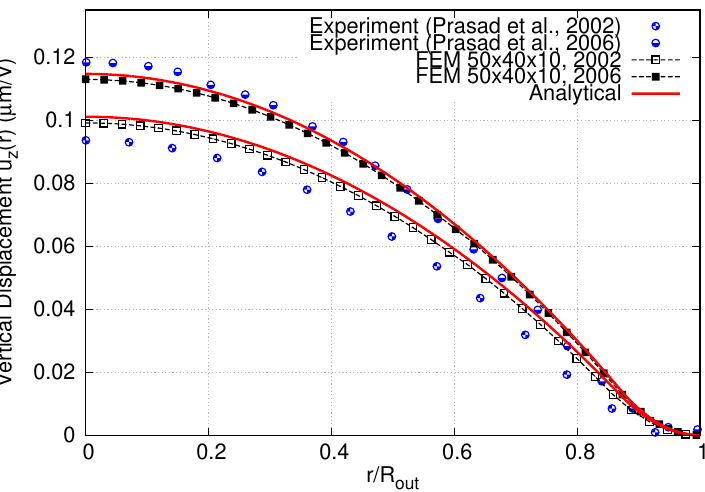
Figure 10. Comparison of different experimental data and FEM results obtained from the present work on the same device APC 850 reported in [18,19]. Here, the experimental (circle symbols) and numerical data (dashed line with square symbols) are shown for two different setups of the same device.